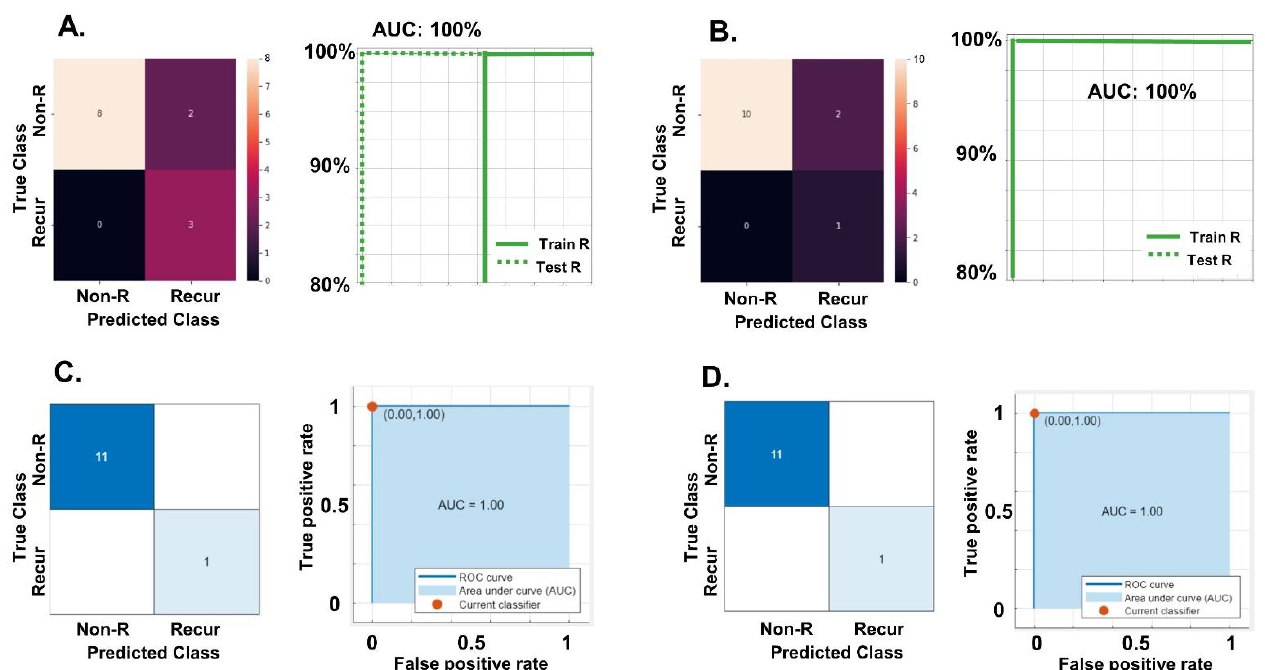
Figure 5. ( A ) Validation of the best model with lncRNA data and FIGO Stage clinical variable (the most informative in the clinical model). These are the results after training and validating the model with TensorFlow in 75% of the samples, and then performing testing on the remaining 25% of the data. We are showing the testing results. The left panel shows the confusion matrix representing the true (True Class) versus the predicted values (Predicted Class). The right panel is an ROC graphic: true positives in the x axis, false positives in the y axis, and AUC results. Train R: results of unbalanced (or re-sampling) model training; Test R: results of re-sampling model testing. AUC of 1.00 and accuracy of 0.92. Recur: recurrent; Non-R: non recurrent. ( B ) Validation of the best model with only lncRNA data and no clinical variables. As before, we are showing testing results in 25% of the data, after training and validating have been performed with TensorFlow. Left and right panels are as before. AUC of 1.00 and accuracy of 0.85. ( C ) Validation of the best model with lncRNA data and FIGO Stage clinical variable performed with MATLAB platform. We are showing testing results in 20% of the data, after training and validating have been performed. MATLAB offers over 30 methods for its machine learning (ML) App. In four of them the accuracy of testing was 100%, as shown in the graphic. Specifically, this is the coarse Gaussian SVM (support vector machines) method. Left and right panels are as before. AUC of 1.00 and accuracy of also of 1. ( D ) Validation of the best model with only lncRNA data and no clinical variables with MATLAB platform. Parameters are as before. This time, most methods had a testing accuracy of 100%. Showing the linear SVM method. Left and right panels are as before. AUC of 1.00 and accuracy of also of 1.